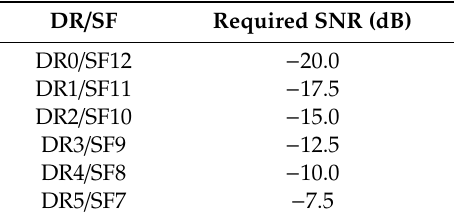
Table 3. Required SNR for